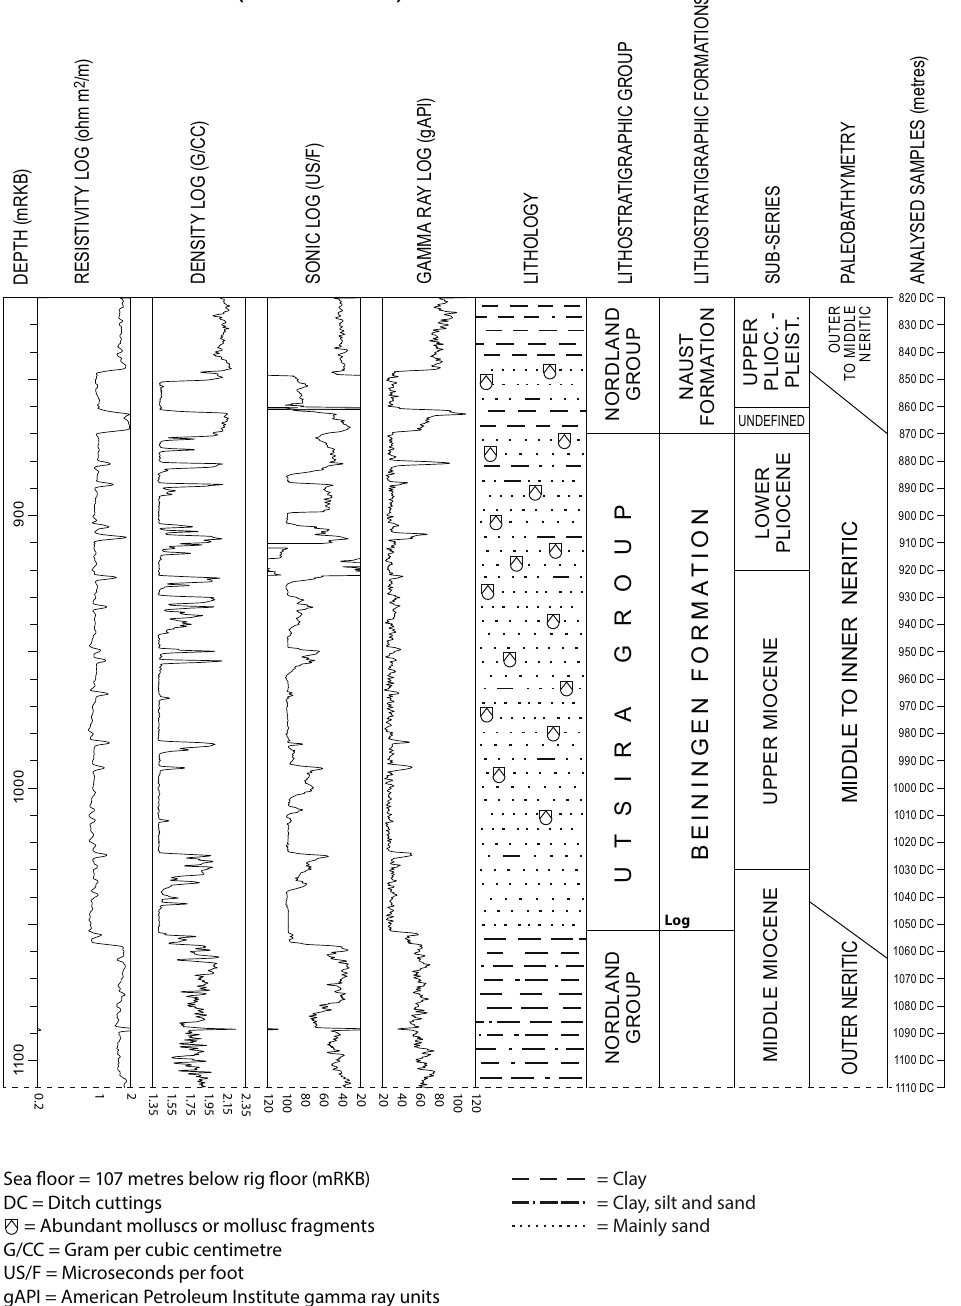
Figure 44. Well summary figure including resistivity log, density log, sonic log, gamma-ray log, lithology, litho- stratigraphic units, sub-series, paleobathymetry and analysed samples for the upper part of the investigated sequence in well 15/9–13 (middle Miocene to upper Pliocene–Pleistocene; modified after Eidvin,